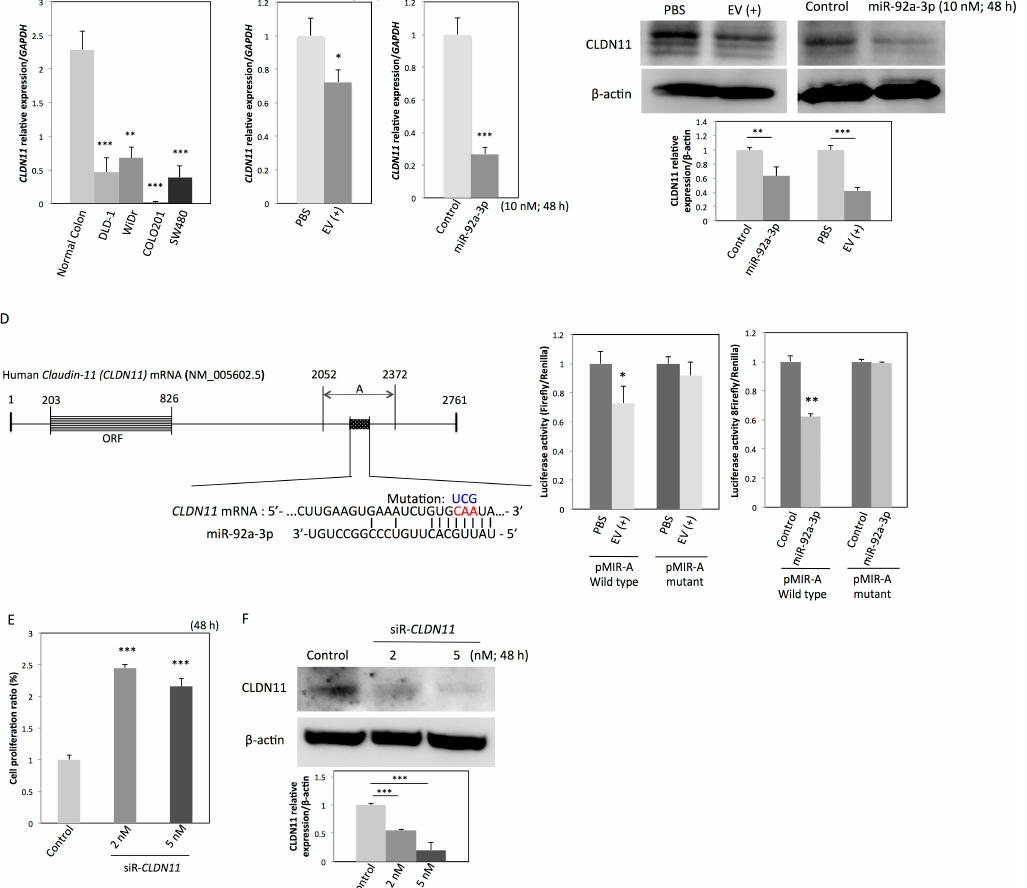
Figure 4. MiR-92a-3p induces a pro-angiogenic state in endothelial cells through the downregulation of CLDN11 . ( A ) Relative expression levels of CLDN11 mRNA in four colon cancer cell lines: GAPDH was used as an endogenous normalizer for CLDN11 expression. ** p < 0.01; *** p < 0.001. ( B ) Relative expression levels of CLDN11 mRNA and ( C ) CLDN11 protein in HUVECs at 48 h after incubation with EVs or transfection with miR-92a-3p or nonspecific control miRNA. * p < 0.05, ** p < 0.01, and *** p < 0.001. ( D ) Predicted binding site for miR-92a-3p in the 3’UTR region of human CLDN11 mRNA (region A shown as a dotted box). Mutant-type pMIR contained a mutated seed sequence (from CAA to UCG). Luciferase activities after incubation with EVs or co-transfection of HUVECs with miR-92a-3p or nonspecific control miRNA and wild-type or mutant pMIR-A vector. ** p < 0.01. ( E ) Cell proliferation ratio and ( F ) relative expression levels of CLDN11 protein at 48 h after transfection of HUVECs with siR- CLDN11 or nonspecific control miRNA. *** p < 0.001. ( G ) Migration assay and ( H ) tube formation assay in HUVECs transfected with siR- CLDN11 or nonspecific control miRNA.